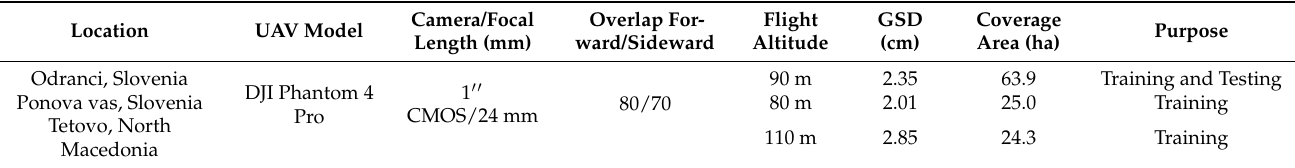
Table 1. Specification of unmanned aerial vehicle (UAV) dataset for the selected study